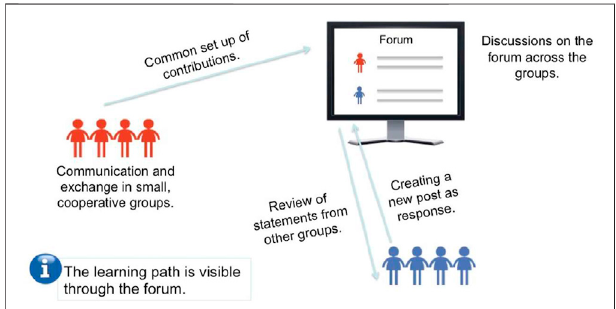
FIGURE 1 | Interaction forms using the